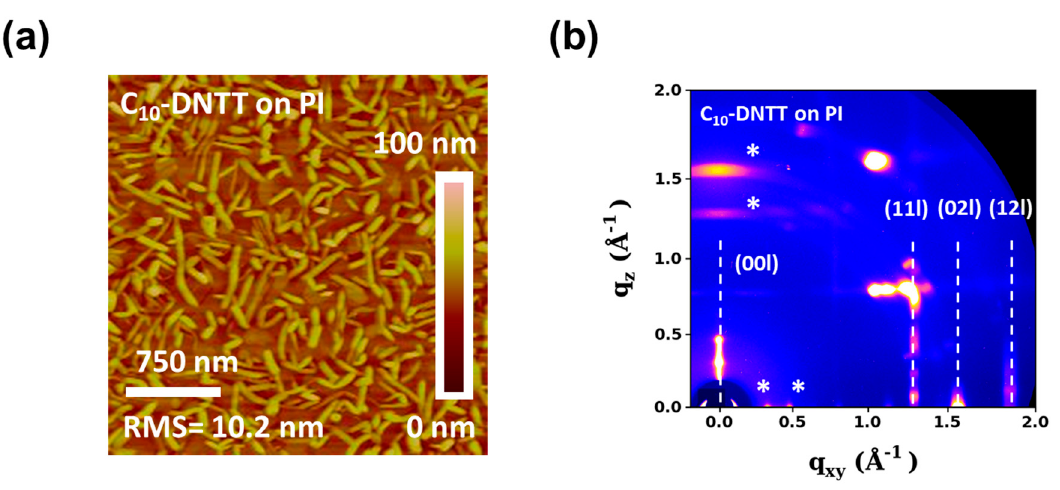
Figure 3. Morphological results of C 10 -DNTT on PI dielectrics: ( a ) AFM and ( b ) 2D-GIXD images.